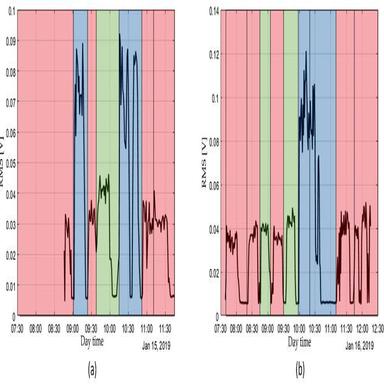
RMS data of two measuring days derived from the AE system with 60 s-averaging.